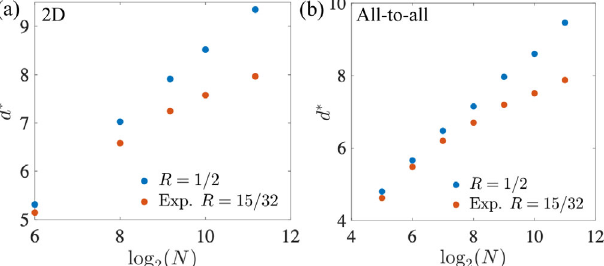
FIG. 8. (a) I ð R 0 ∶ E 0 Þ for the Haar random encoding following a 1 − R Þ = 2 , fixed-fraction erasure error at R ¼ 1 = 2 . For e < e c ¼ ð I ð R 0 ∶ E 0 Þ rapidly decays to zero, whereas it grows to an extensive value for e > e . (b) Finite-size scaling in the IID erasure model. c Inset: scaled I ð R 0 ∶ E 0 Þ with an unscaled erasure rate. The curves for different system sizes cross near the channel capacity bound 1 = 4 e c ¼